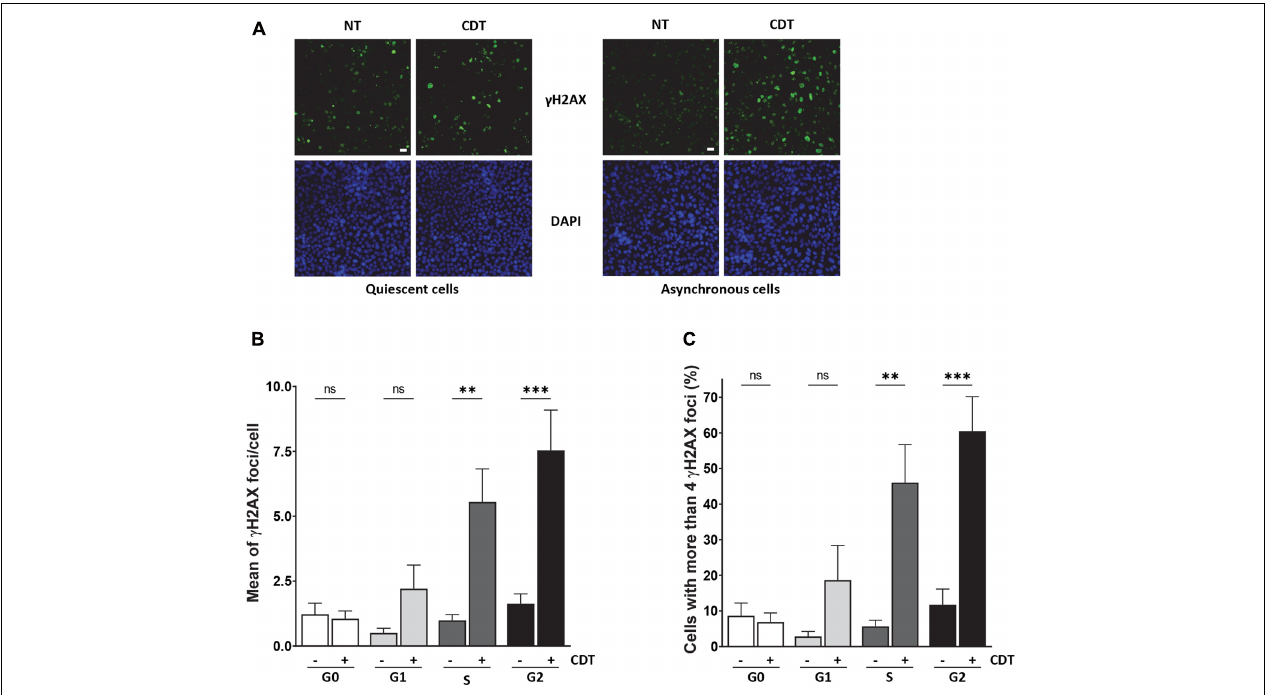
FIGURE 5 | CDT induces γ H2AX foci formation preferentially in proliferating cells. (A) Representative images of γ H2AX (green) immunostaining in quiescent or proliferating RKO cells after exposure or non-exposure (NT) with E. coli CDT (25 ng/ml) for 7 h. DNA was stained with DAPI (blue). Scale bar: 20 µ m. (B) Quantification by ArrayScan analysis of γ -H2AX foci formation in quiescent or proliferating RKO cells sorted according to cell cycle phase after CDT treatment from E. coli (25 ng/ml) for 7 h. (C) Quantification of γ H2AX-positive cells with > 4 foci/nuclei in cells treated as in (B) . For each analysis, a minimum of 1,000 cells were analyzed with a wide-field fluorescent microscope (ArrayScan technology) in three independent experiments [ ∗∗ P < 0.01, ∗∗∗ P < 0.001 versus non-treated (NT); ns, not